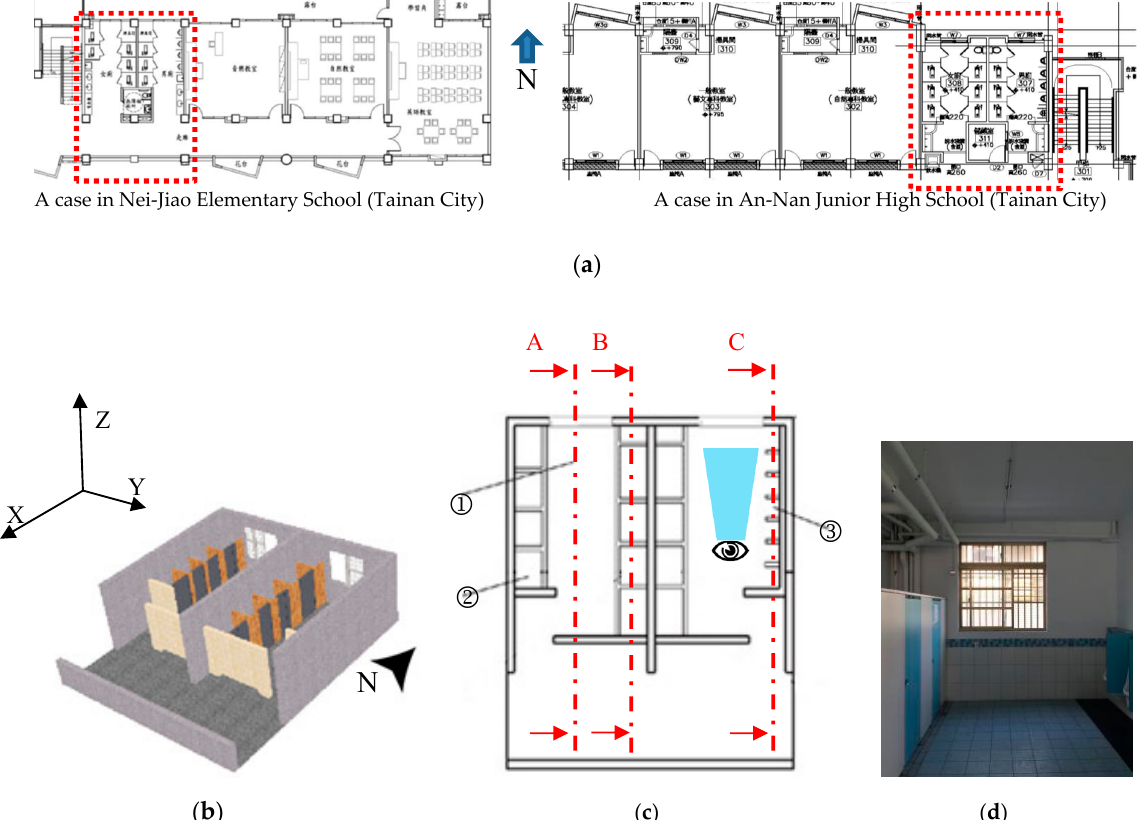
Figure 1. Study subject. ( a ) The investigated model restroom comes from practical cases (red dotted area) (not to scale). ( b ) 3D diagram. ( c ) Plan. ( d ) Field image.